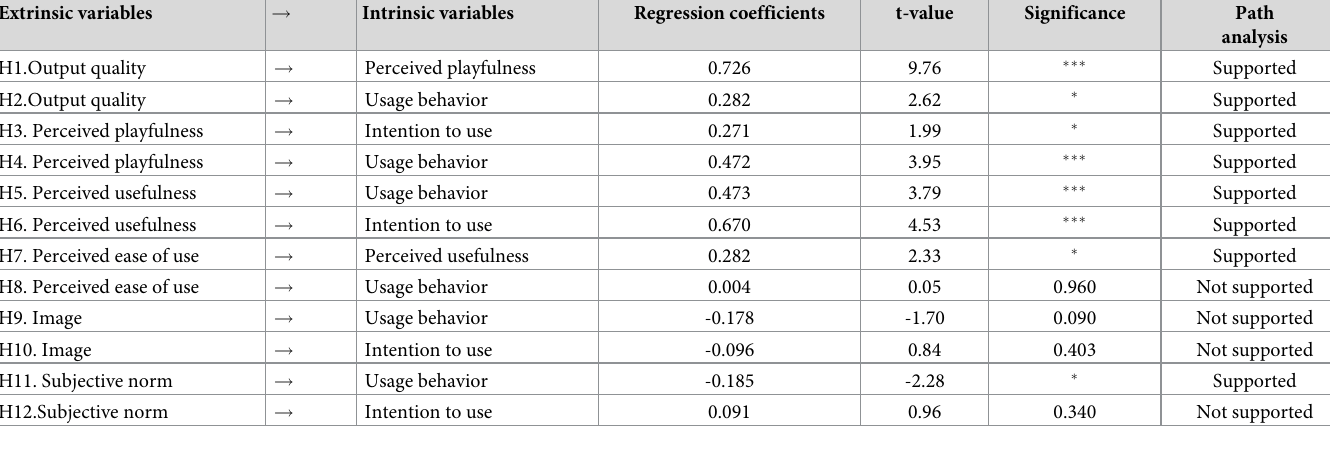
Table 9. TAM2 analysis of research hypotheses pertaining to cognitive